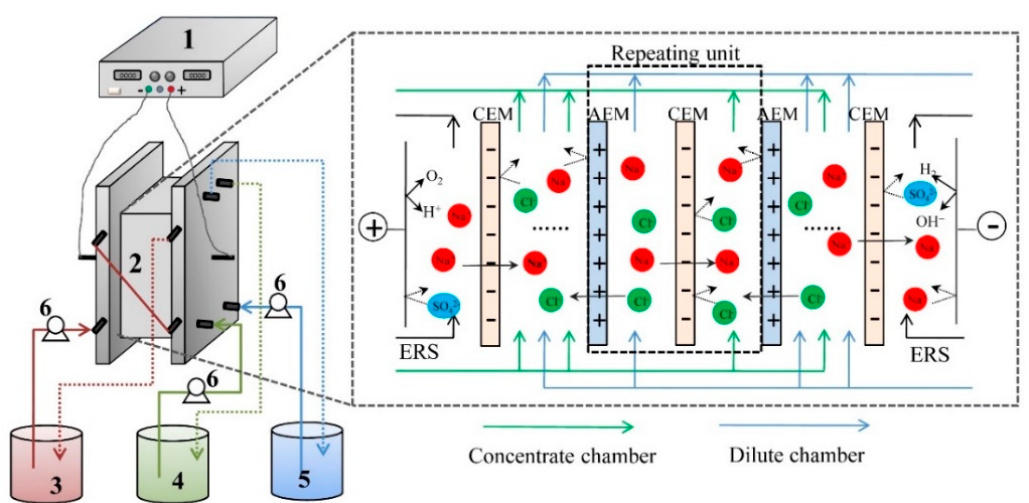
Figure 1. The main principle of electrodialysis for desalting of tobacco sheet extract. ( 1 ) Direct current supply; ( 2 ) Electrodialysis (ED) membrane stack; ( 3 ) Electrode rinse chamber; ( 4 ) Concentrate chamber; ( 5 ) Dilute chamber; and ( 6 ) Pump.